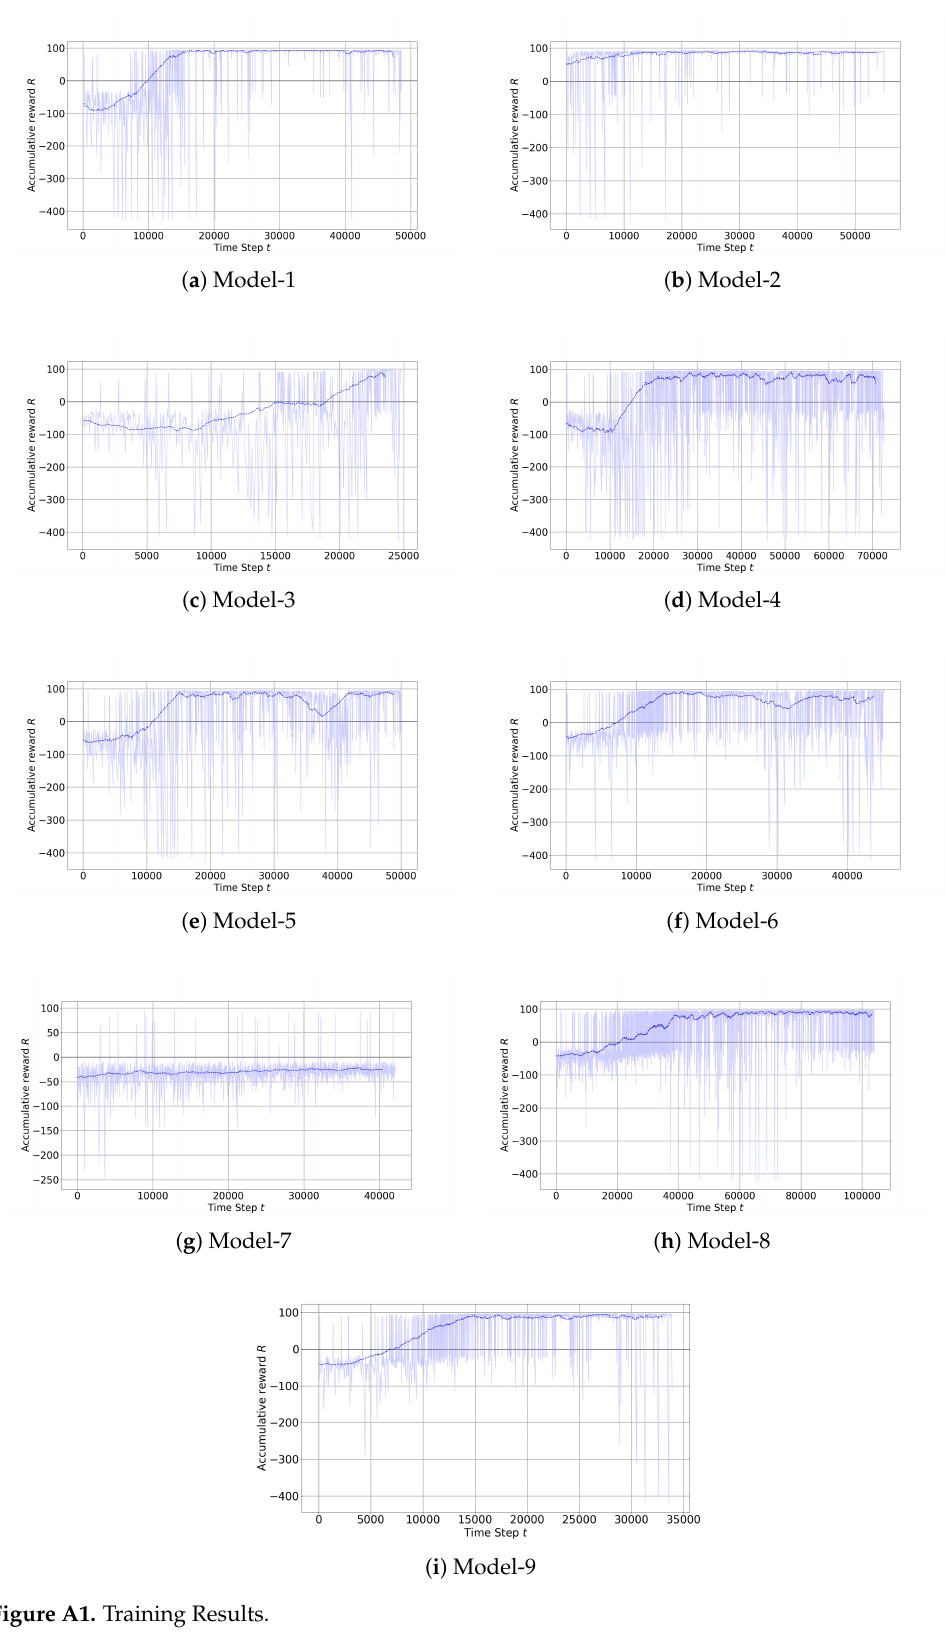
Figure A1. Training